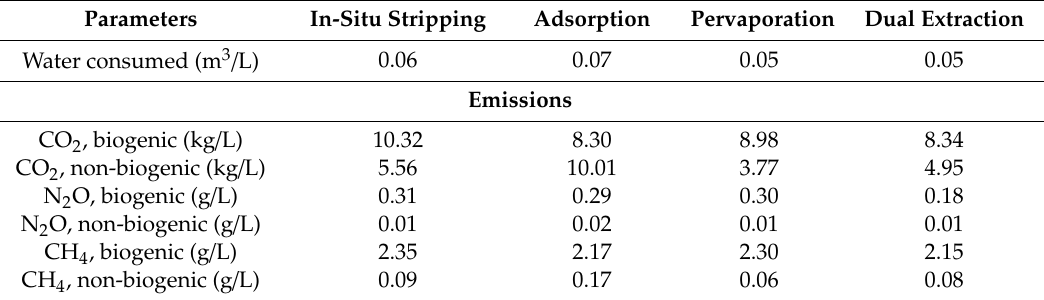
Table 7. Water consumed and emissions from di ff erent product separation models